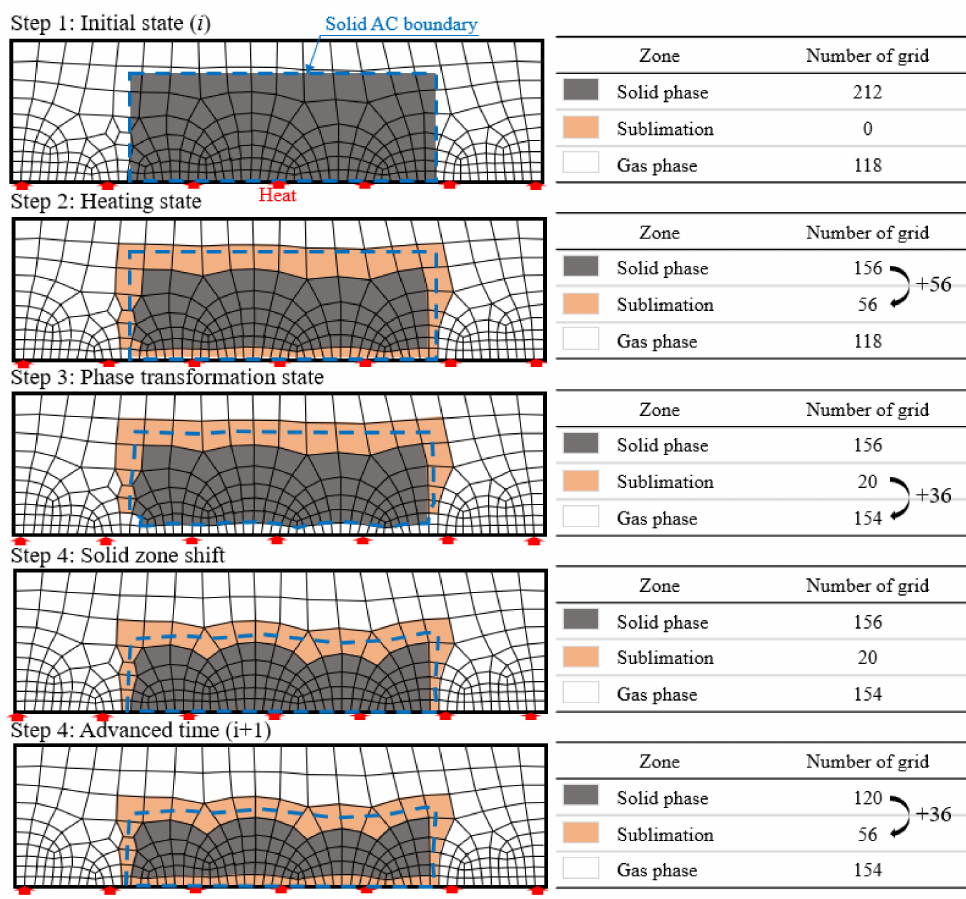
Figure 3. Concept of the model: Changes in the shape and location of solid AC where sublimation occurs due to heat